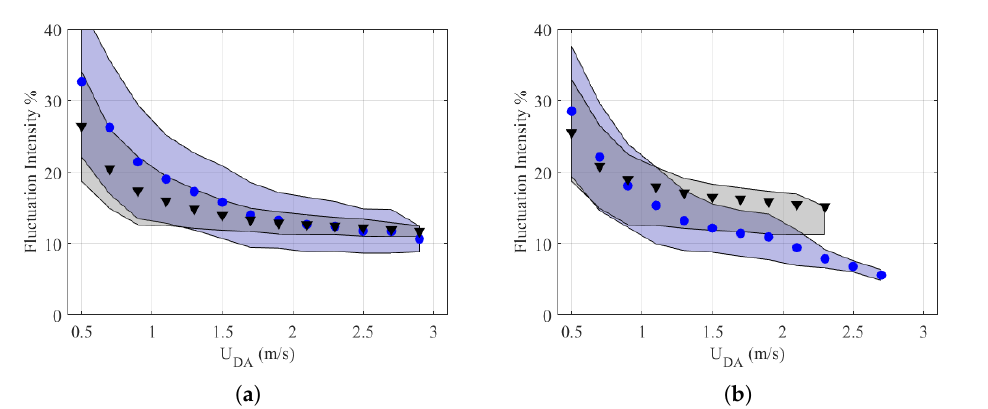
Figure 6. Variation of fluctuation intensity at each hub height and site location, with solid markers showing the mean and shaded region given to show the range around the mean, blue band/blue marker—near surface position, grey band/black marker—near bed position. ( a ) Location A. ( b ) Lo- cation B.